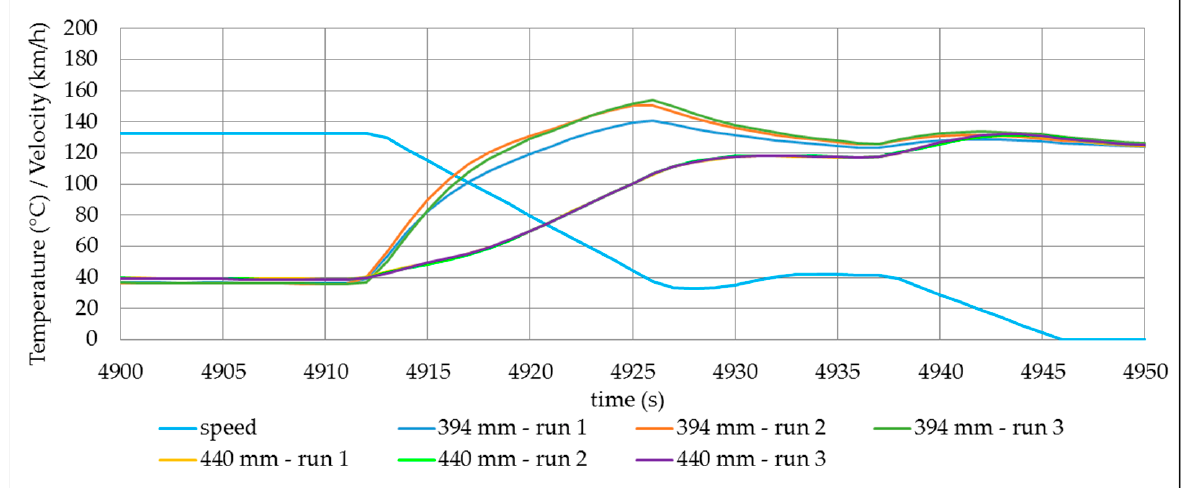
Figure 15. Temperature profile of the tungsten carbide-coated (HMC) discs along brake event 106 of trip #10 of the WLTP brake cycle (Vehicles 1 and 2).